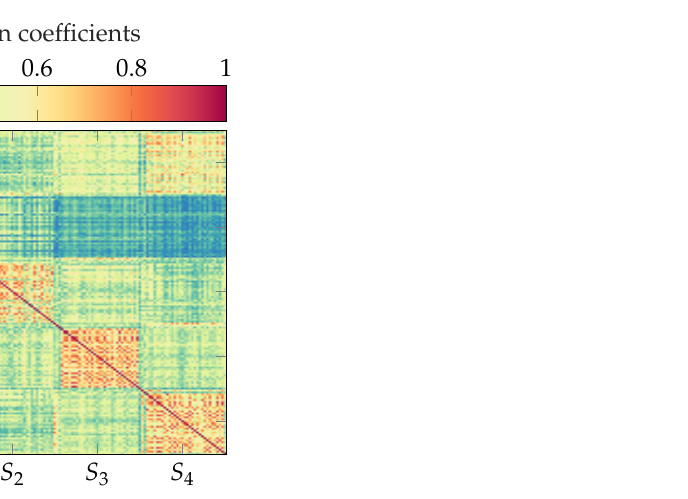
Figure 9. Maximum correlation coefficients of the cross-correlation of all signals for the gearbox with damage at gear z 1 .